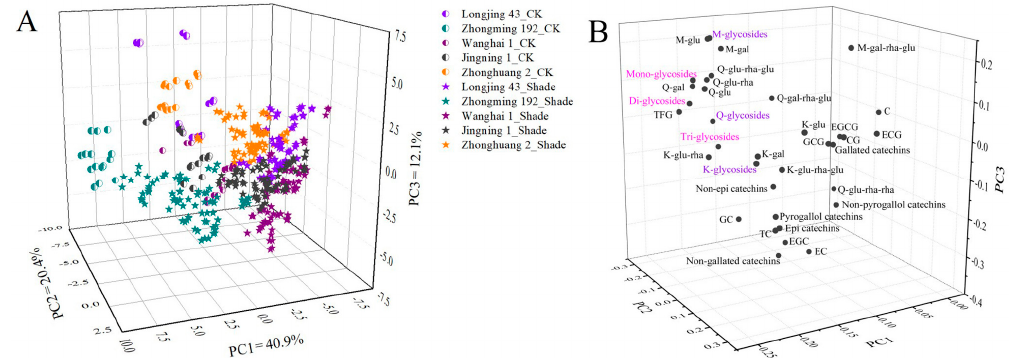
Figure 6. The PCA results for the tea samples of different cultivars under shade treatments based on flavonoid composition: ( A ) score plot; ( B ) loading plot. The number of replicates was equal to 3.